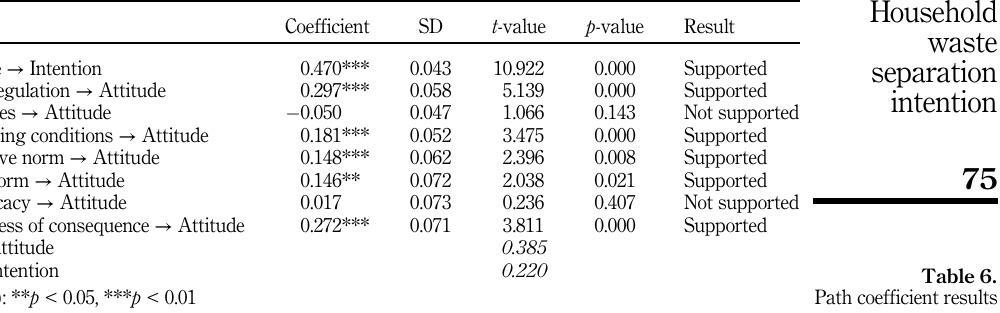
Table 6. Path coefficient